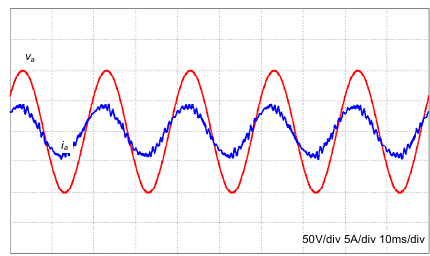
Figure 8. The simulation results of input current and input voltage.